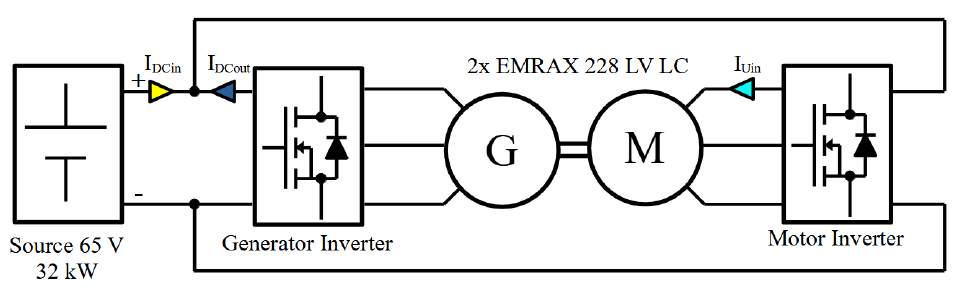
Figure 26. Back-to-back test